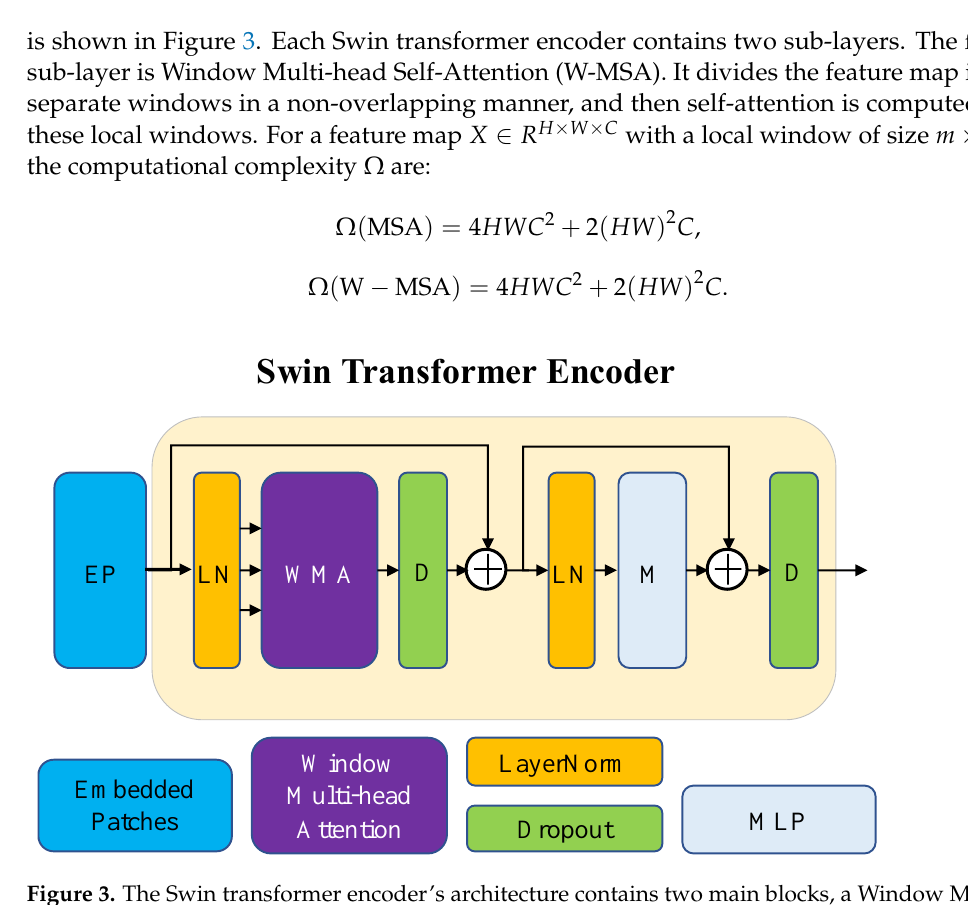
Figure 3. The Swin transformer encoder’s architecture contains two main blocks, a Window Multi- head Self-Attention (W-MSA) and a Multi-Layer Perceptron (MLP). LayerNorm and Dropout layers help the network to converge better and prevent the network from overfitting.